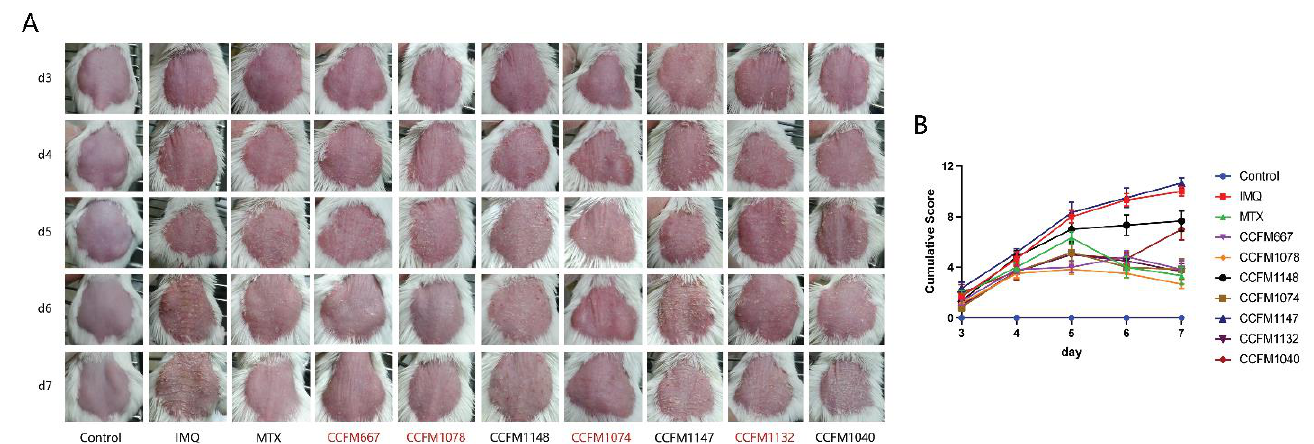
Figure 2. Effects of probiotics on dorsal skin. ( A ) Representative photographs of dorsal skin of mice from D3 to D7. ( B ) PASI of mice in different groups. Cumulative Score is the sum of the scores of the severity of thickening, scaling, and erythema.